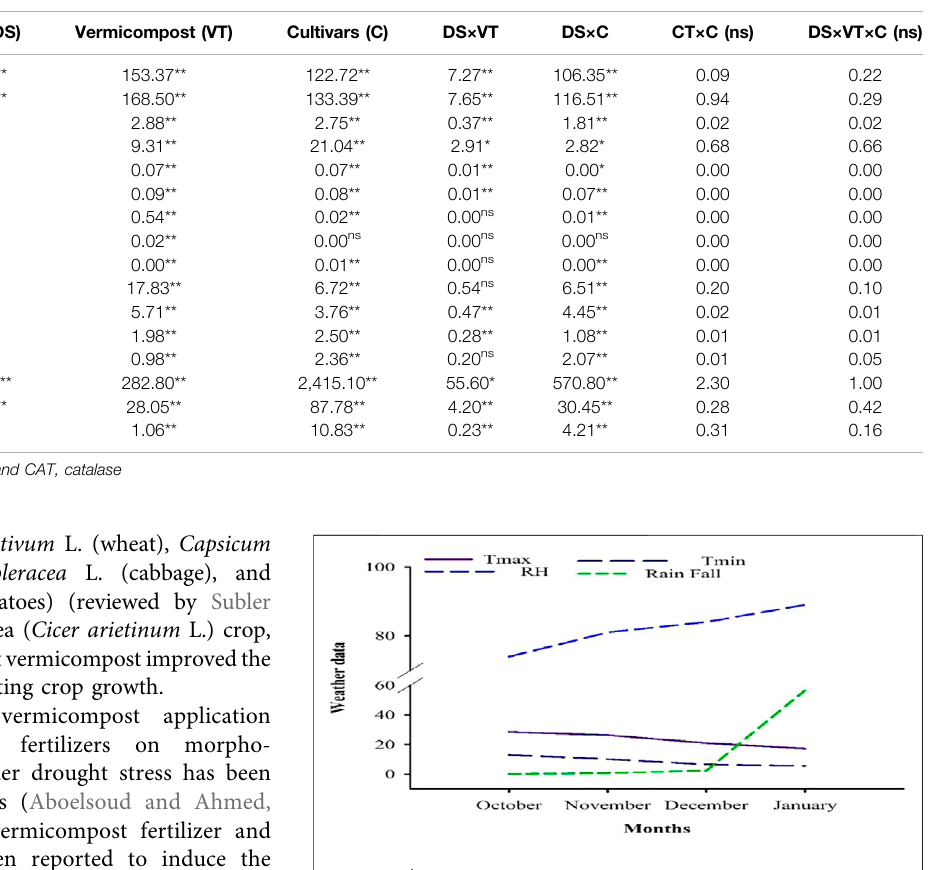
FIGURE1| Meteorologicaldata,meanmonthlymaximumandminimum temperatures(TmaxandTmin,respectively),relativehumidity(RH),andrainfall during the crop growing